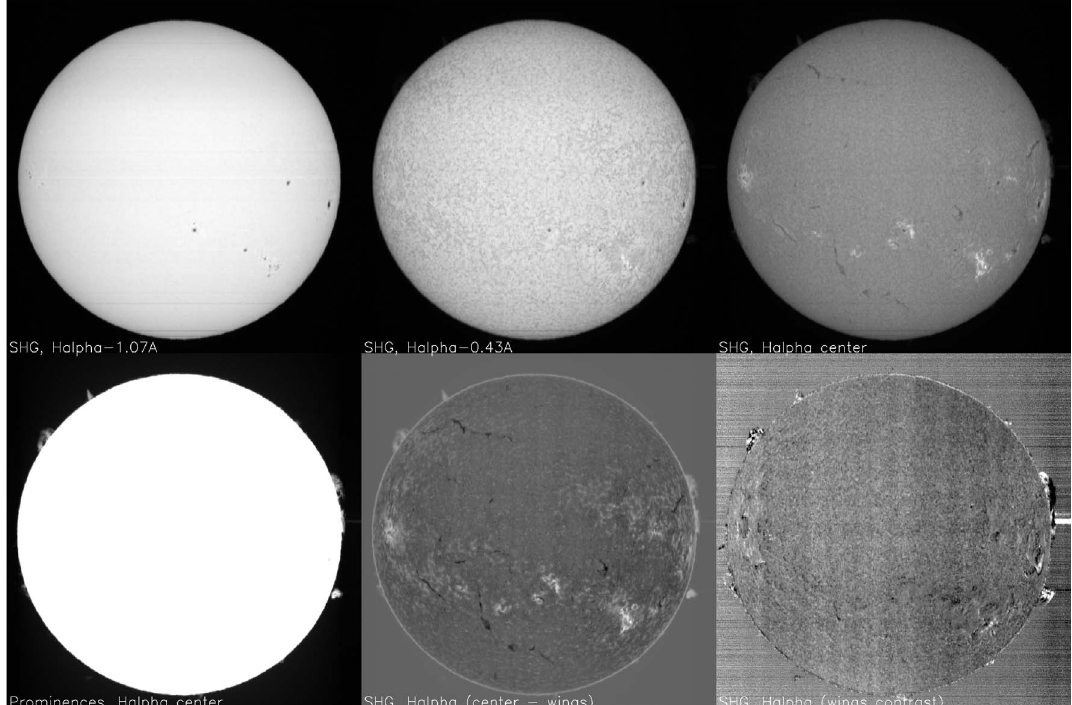
Fig. 7. Typical images issued from H a datacubes produced by the Spectroheliograph. Top (left to right): continuum ( (cid:4) 1.07 Å), blue wing ( (cid:4) 0.43 Å) and line core. Bottom (left to right): limb prominences, composite image (line center minus red and blue wings) and Doppler proxy (contrast between both